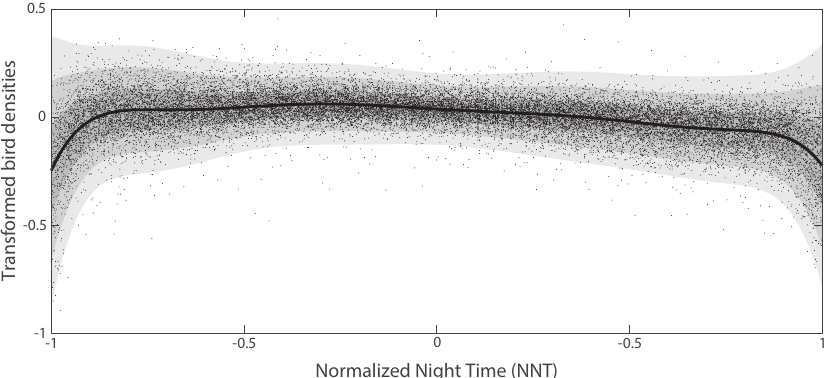
Figure A4. Intra-night scale component of the weather radar data (black dots) and fitted curve trend (black line). The shaded gray areas each denote 1-, 2-, and 3- σ I